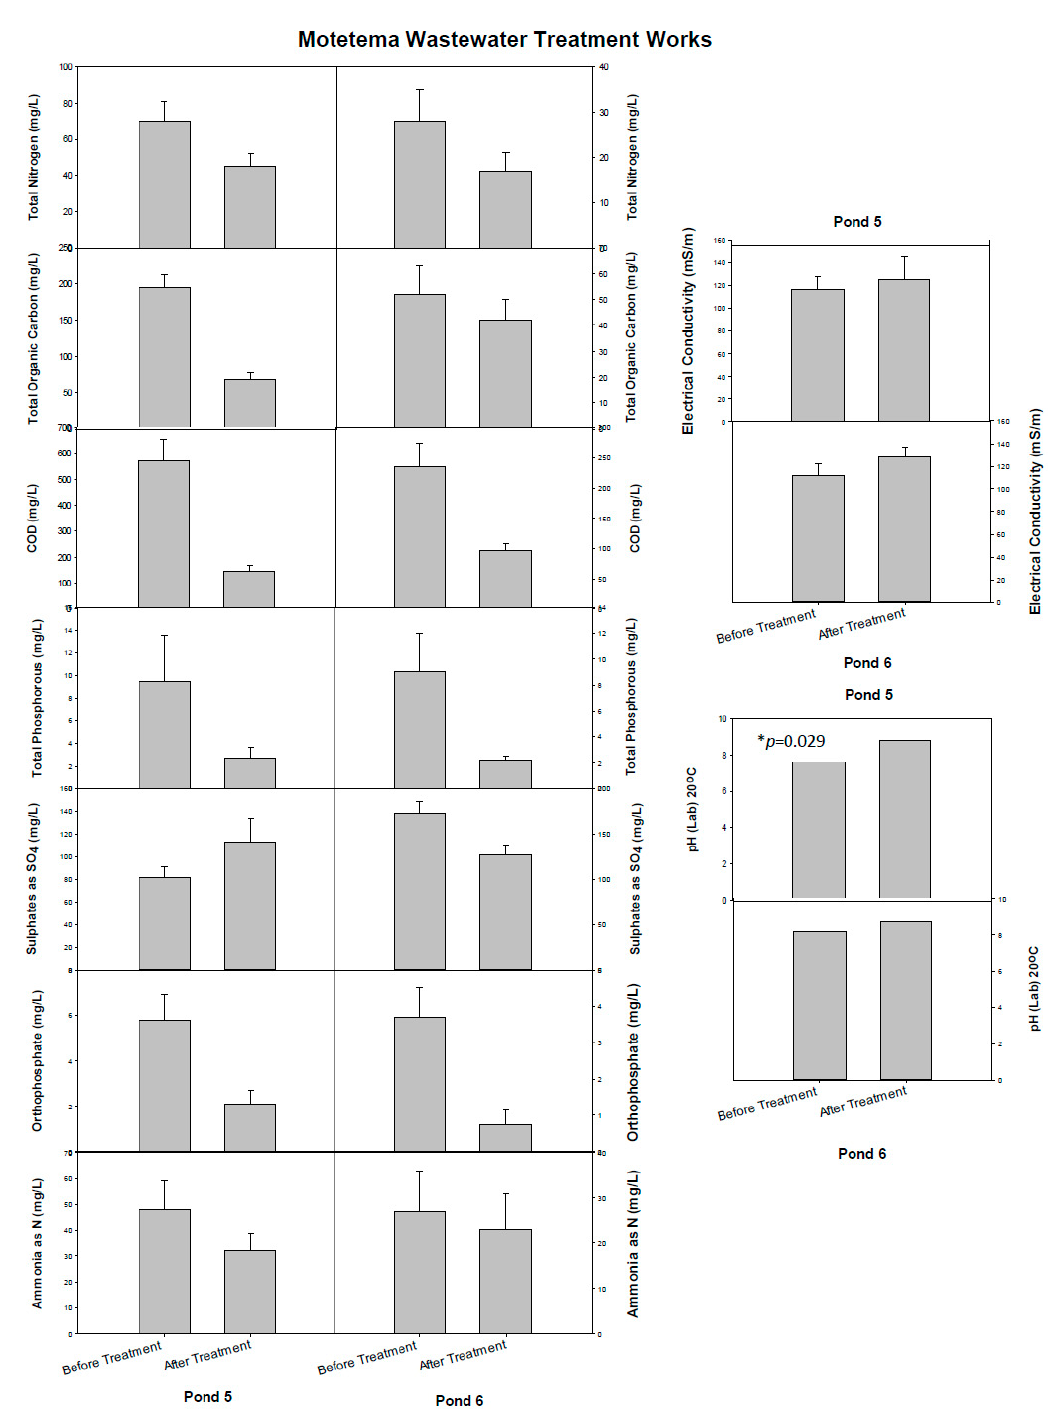
Figure 4. Water quality results from Motetema wastewater pond treatment plants before and after phycoremediation treatment. * p -values shown for those parameters that were statistically significantly different before and after treatment.